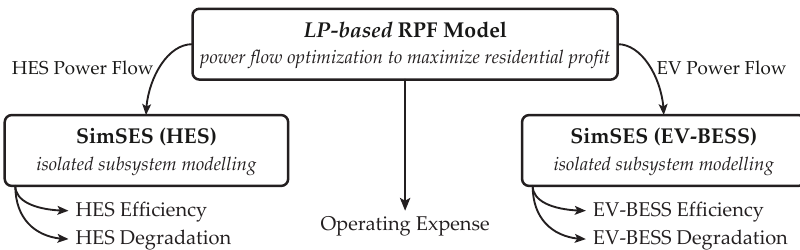
Figure 2. Schematic diagram of the two-step model structure, consisting of a linear programming (LP) based residential power flow (RPF) model, which optimizes the power flows so that the operating expenses (OPEX) are minimized, and the simulation tool SimSES , which validates the technical characteristics, round-trip efficiency, and battery degradation of the battery energy storage systems (BESSs).